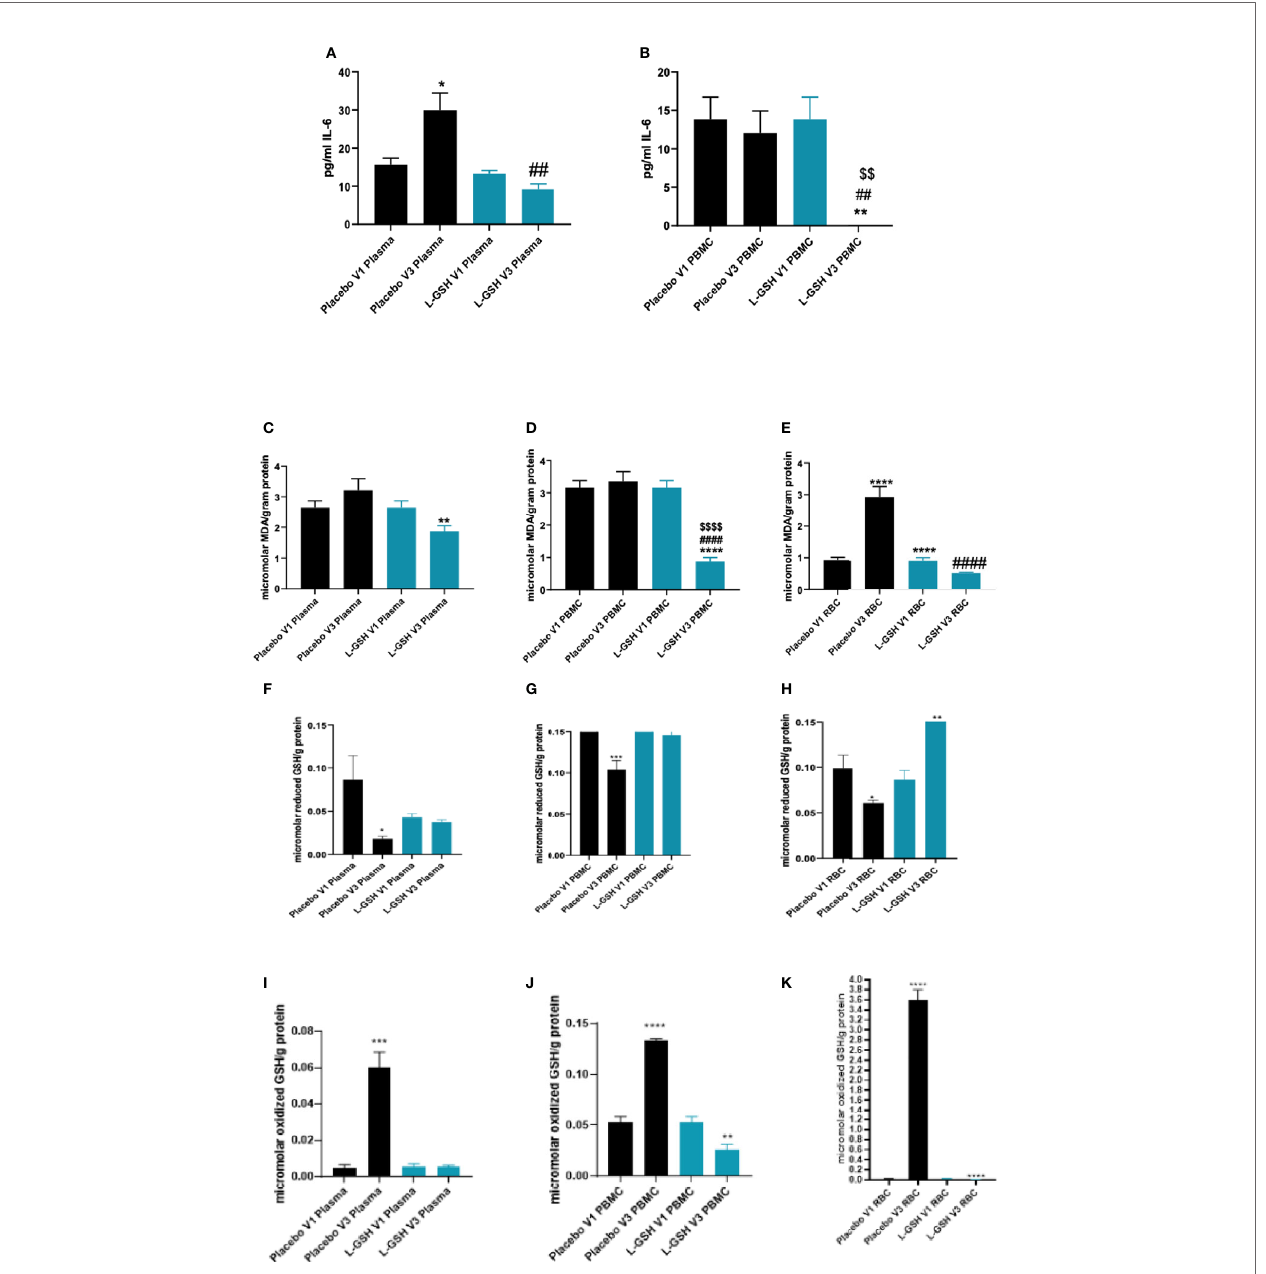
FIGURE 4 | Clinical trial fi ndings. Quanti fi cation of IL-6, MDA and GSH in blood samples from individuals with T2DM on L-GSH/or placebo supplement. Levels of IL-6 in the plasma (A) and PBMCs (B) isolated from individuals with T2DM at pre- and post- L-GSH/or placebo supplementation were determined by spectrophotometry using an assay kit from Invitrogen. V1 represents plasma samples (A) or PBMCs (B) isolated from subjects with T2DM prior to L-GSH/or placebo supplementation. V3 represents plasma samples (A) or PBMCs (B) isolated from subjects with T2DM at three months post- L-GSH/or placebo supplementation. Levels of malondialdehyde in the PBMCs (C) , plasma (D) , and RBCs (E) isolated from individuals with T2DM at pre- and post- L-GSH/or placebo supplementation were determined by spectrophotometry using an assay kit from Invitrogen. V1 represents plasma (C) , PBMCs samples (D) , or RBCs (E) isolated from subjects with T2DM prior to L-GSH/or placebo supplementation. V3 represents plasma (C) , PBMCs samples (D) , or RBCs (E) isolated from subjects with T2DM at three months post- L-GSH/or placebo supplementation. V1 represents samples isolated from subjects with T2DM prior to L-GSH/or placebo supplementation. V3 represents samples isolated from subjects with T2DM at three months post- L-GSH/or placebo treatment. Levels of reduced form of GSH (F – H) ) and oxidized form of GSH (GSSG) (I – K) in the plasma (F, I) , PBMCs (G, J) , and RBCs samples (H, K) isolated from individuals with T2DM at pre- and post- L-GSH/or placebo supplementation were determined by spectrophotometry using an assay kit from Invitrogen. V1 represents samples isolated from subjects with T2DM prior to L-GSH/or placebo supplementation. V3 represents samples isolated from subjects with T2DM at three months post- L-GSH/or placebo treatment. A p <0.05 is considered signi fi cant indicated by an asterisk (*), (**) indicates a p <.005, (***) indicates p <0.0005, (****) indicates p <0.0001, (##) indicates a p <.005, (####) indicates p <0.0001, ($$) indicates a p <.005, ($$$$) indicates p